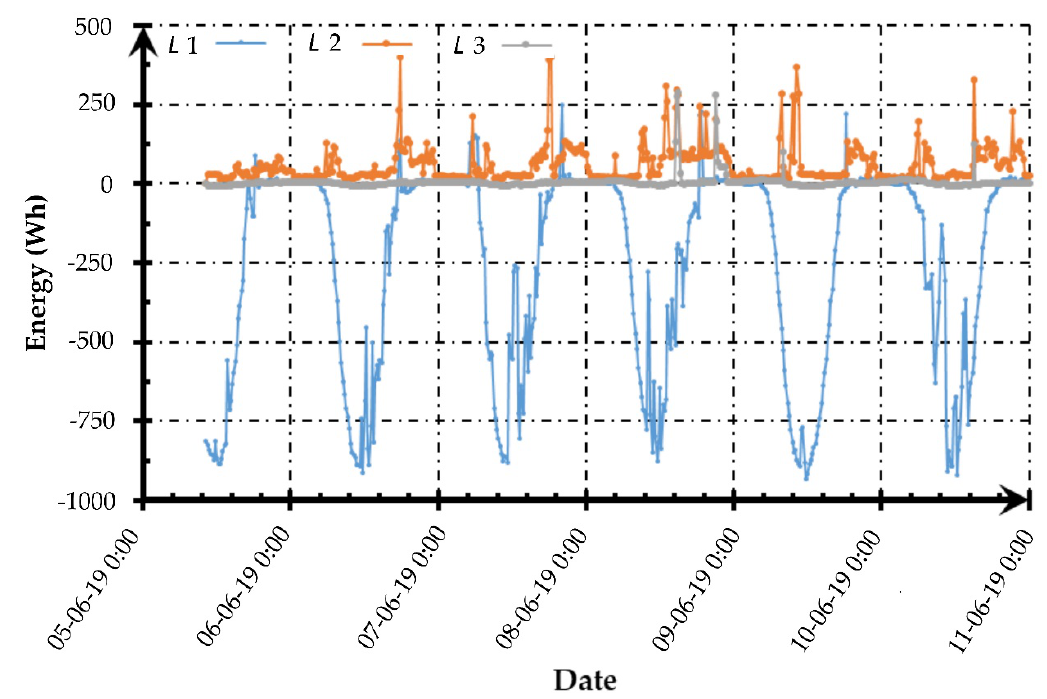
Figure 10. Currents variation during measurements.